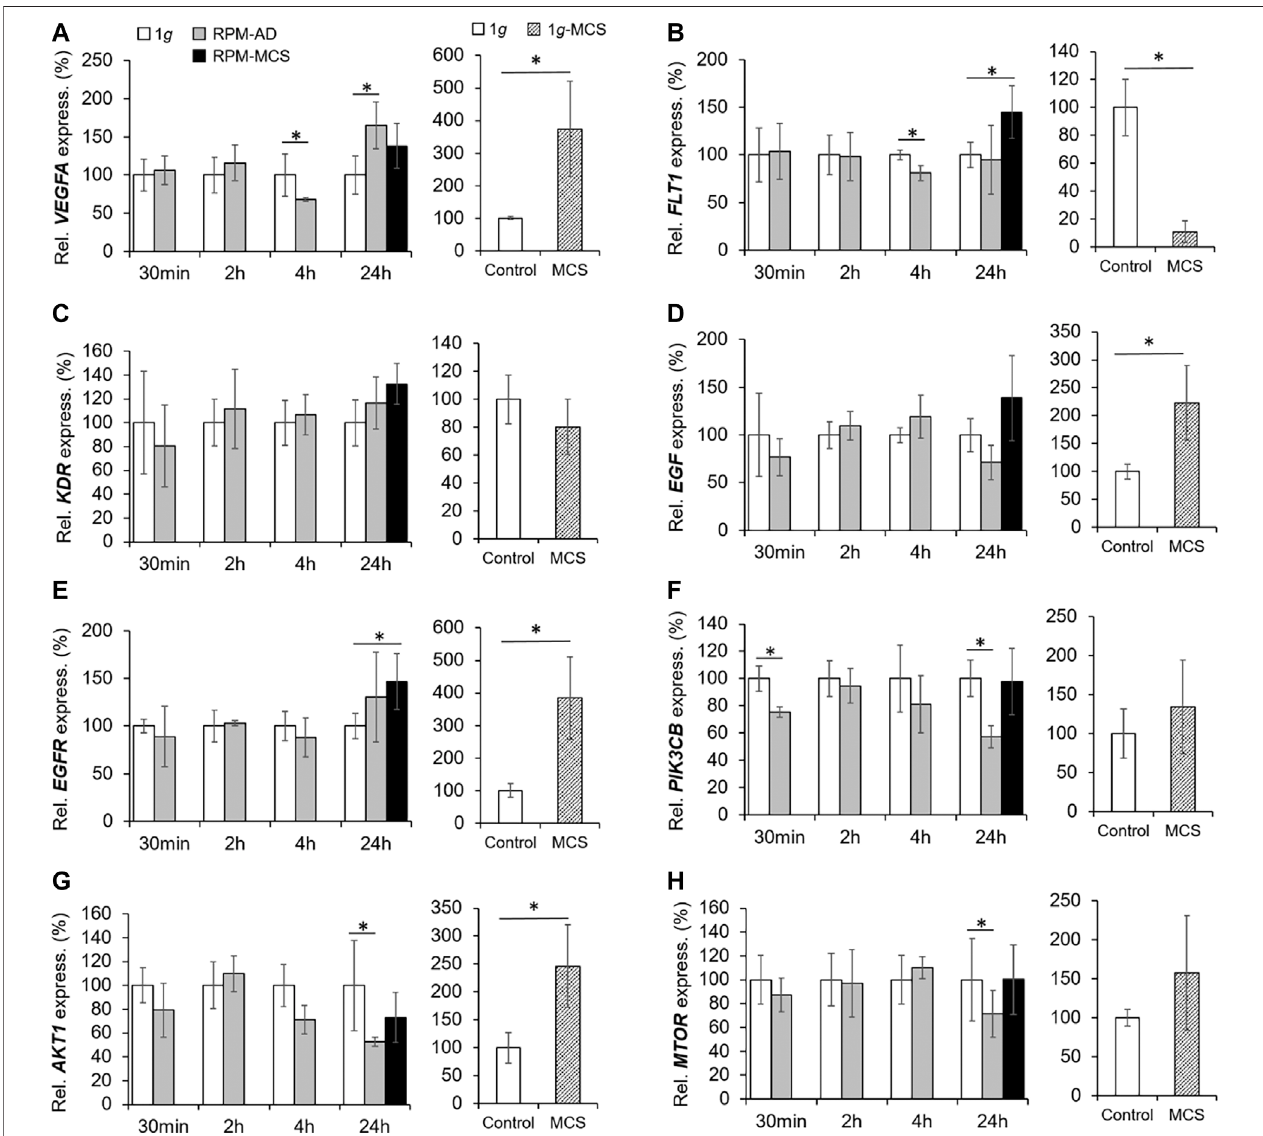
FIGURE7| VEGF,EGF and PAMsignaling: Geneexpression of (A) VEGFA , (B) FLT1 , (C) KDR , (D) EGF , (E) EGFR , (F) PIK3CB , (G) AKT1, and (H) MTOR ofPC-3 cells exposed to the RPM for 30min, 2, 4 and 24 h and 1 g -MCS after 24 h. n = 5 * p < 0.05 vs. 1 g .